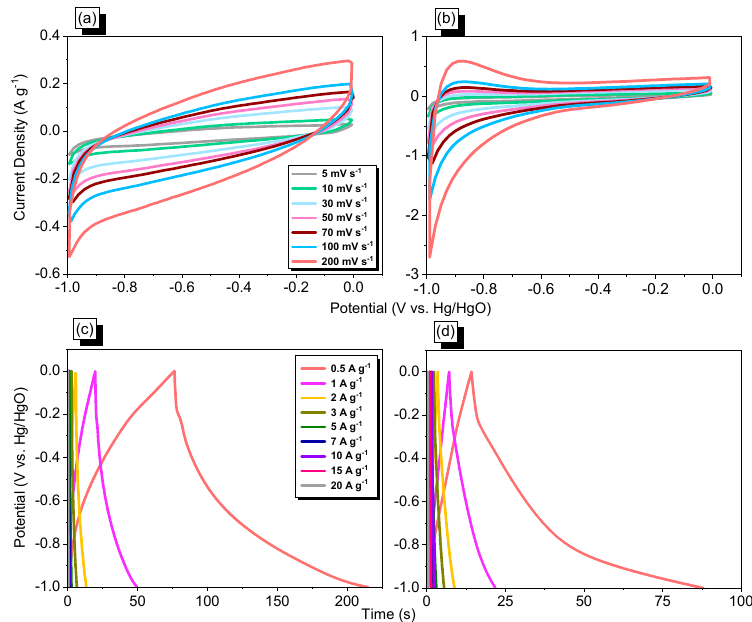
Figure 5. CV ( a , b ) and GCD ( c , d ) curves of TBN-BSU CMP ( a , c ) and Py-BSU CMP ( b , d ). As shown in Figure 6a, at a current density of 0.5 A g − 1 , the speci fi c capacitance values of Py-BSU CMP and TBN-BSU CMP calculated by GCD curves were 38 and 70 F g − 1 . In contrast, TBN-BSU CMP exhibited superior electrochemical behavior due to the more ex- tended conjugated structure of the TBN unit and high surface area. The improvement of the π system increased the charge transfer e ffi ciency in contact with the electrolyte and further promoted the performance of the supercapacitor through this process. From an- other point of view, the capacitance value shrunk when the current density increased from 0.5 to 20 A g − 1 . This can be a tt ributed to the di ff usion problem caused by electrolyte ions not fully permeating into the electrode material due to insu ffi cient time in the high current environment. Figure 6b,c demonstrate the measured stability over 2000 cycles at a current density of 10 A g − 1 . The capacitance retention rates of Py-BSU CMP and TBN-BSU CMP were 99.8% and 99.9%, respectively. The extremely small capacitance decay indicates that the material has excellent electrochemical reversibility. Figure 6d shows that the speci fi c capacitance value of TBN-BSU CMP precursor (70 F g − 1 ) is higher than CoPc-CMP (13.8 F